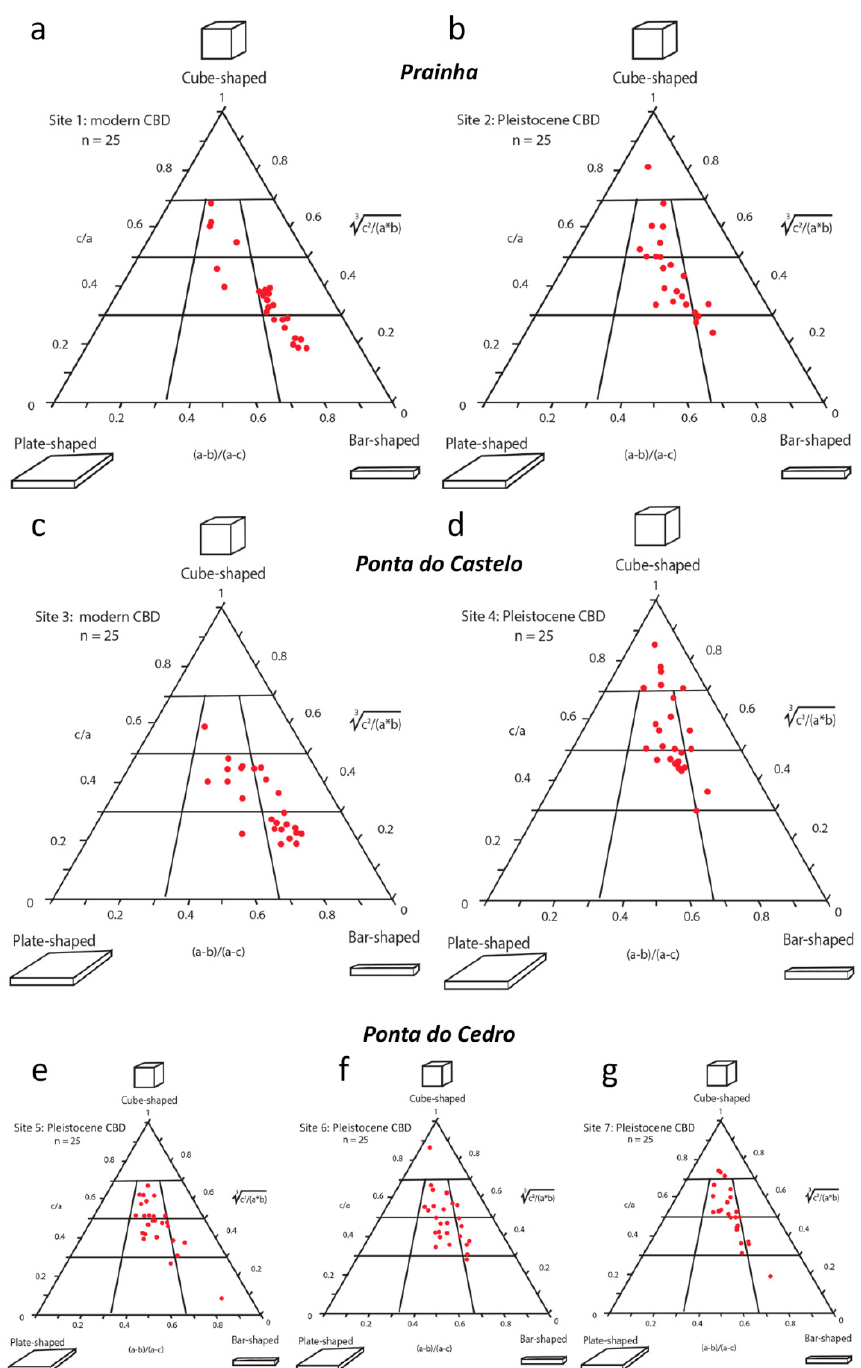
Figure 4. Set of triangular Sneed-Folk diagrams used to show variations in boulder and cobble shapes compared between modern and Pleistocene (MIS 5e) deposits. ( a ), ( b ): Prainha. ( c ), ( d ): Ponta do Castelo. ( e )–( g ): Ponta do Cedro. ( a ), ( c ): modern CBD at Prainha and Ponta do Castelo, respectively. ( b ), ( d ), ( e )–( g ): Pleistocene (MIS 5e) CBD at Prainha, Ponta do Castelo, and Ponta do Cedro, respectively.